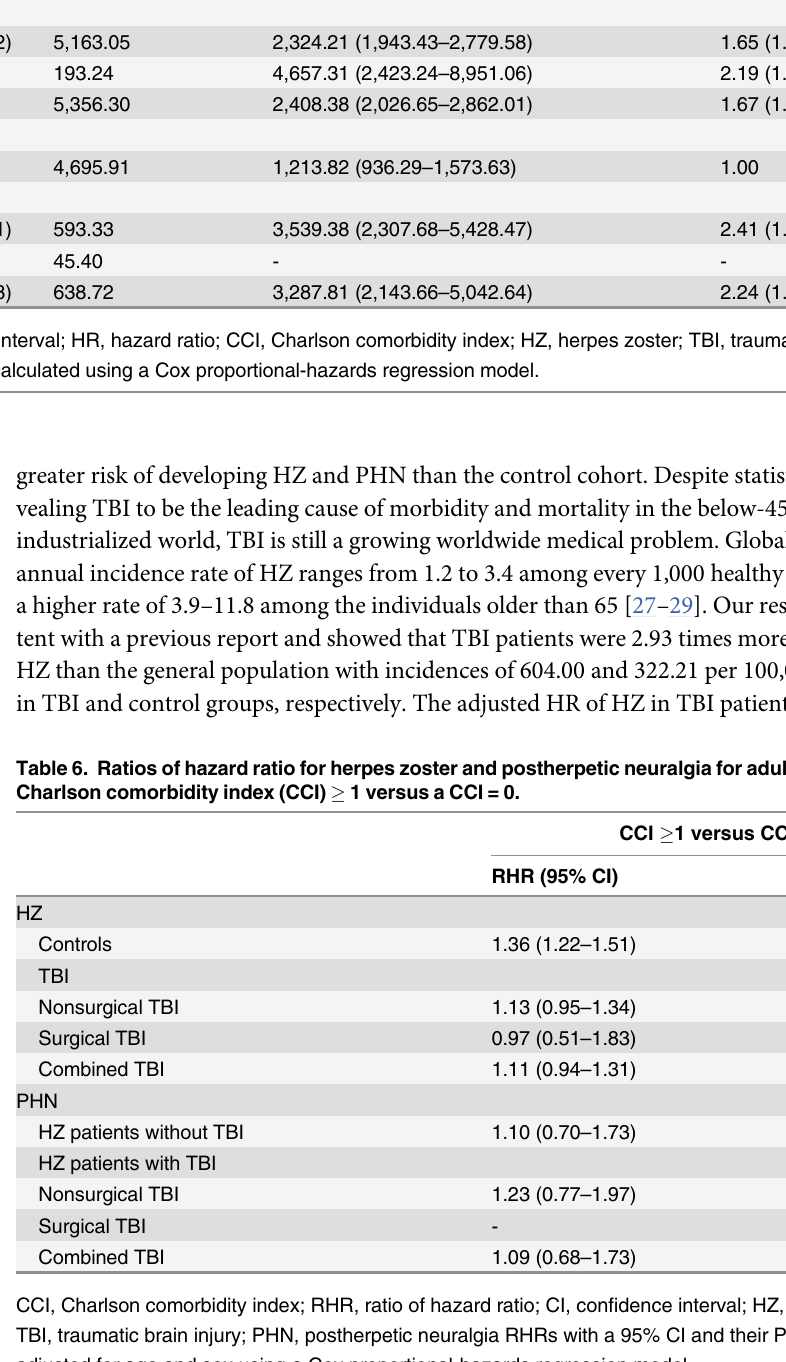
TBI, traumatic brain injury; PHN, postherpetic neuralgia RHRs with a 95% CI and their P values were adjusted for age and sex using a Cox proportional-hazards regression